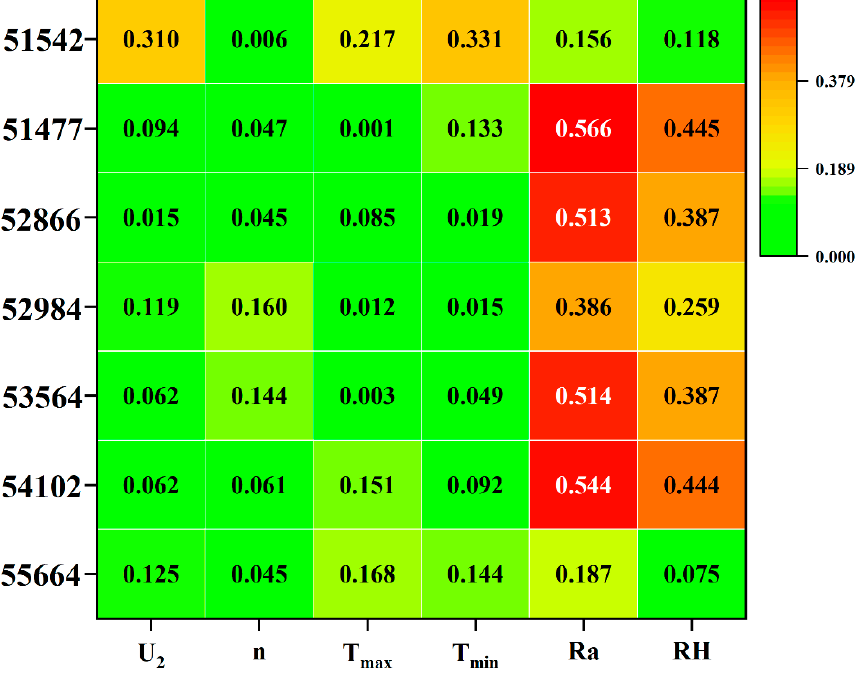
Figure 5. PCCs coefficient of meteorological factors to ET O